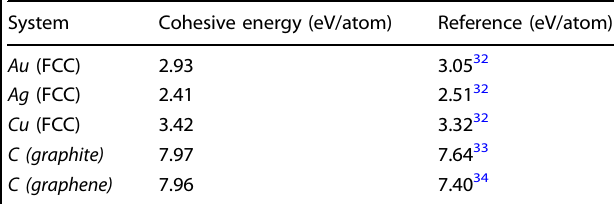
Table 1. Ground-state cohesive energy calculated using PBE for Au (FCC), Ag (FCC), Cu (FCC), and C ( graphite , graphene ), compared with the results of previous DFT